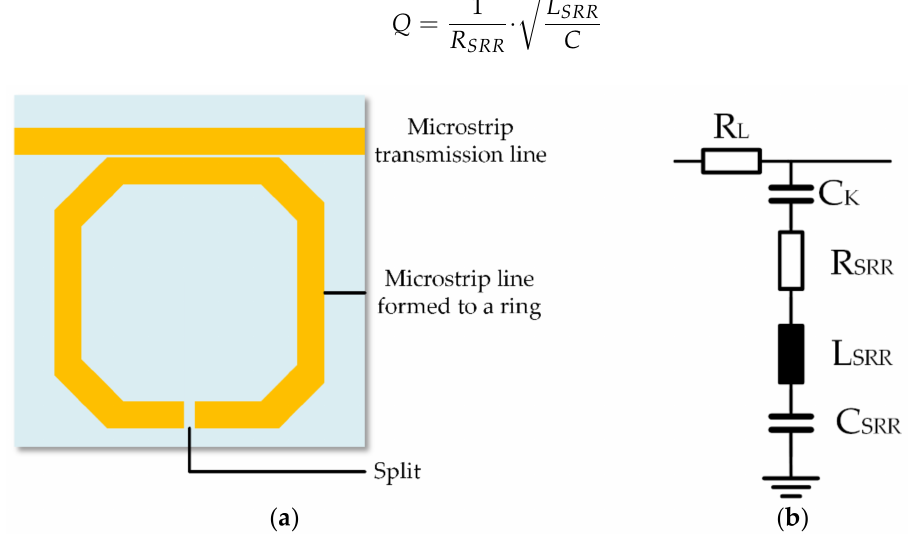
Figure 1. ( a ) Schematic of a split-ring resonator consisting of a printed circuit board with two mi- crostrip lines, one formed to a ring with a split; ( b ) equivalent circuit of the SRR with the ohmic resistance of the transmission line R L , the coupling capacitance C K , the ohmic resistance of the ring R SRR , the inductance of the ring L SRR and the capacitance of the ring C SRR